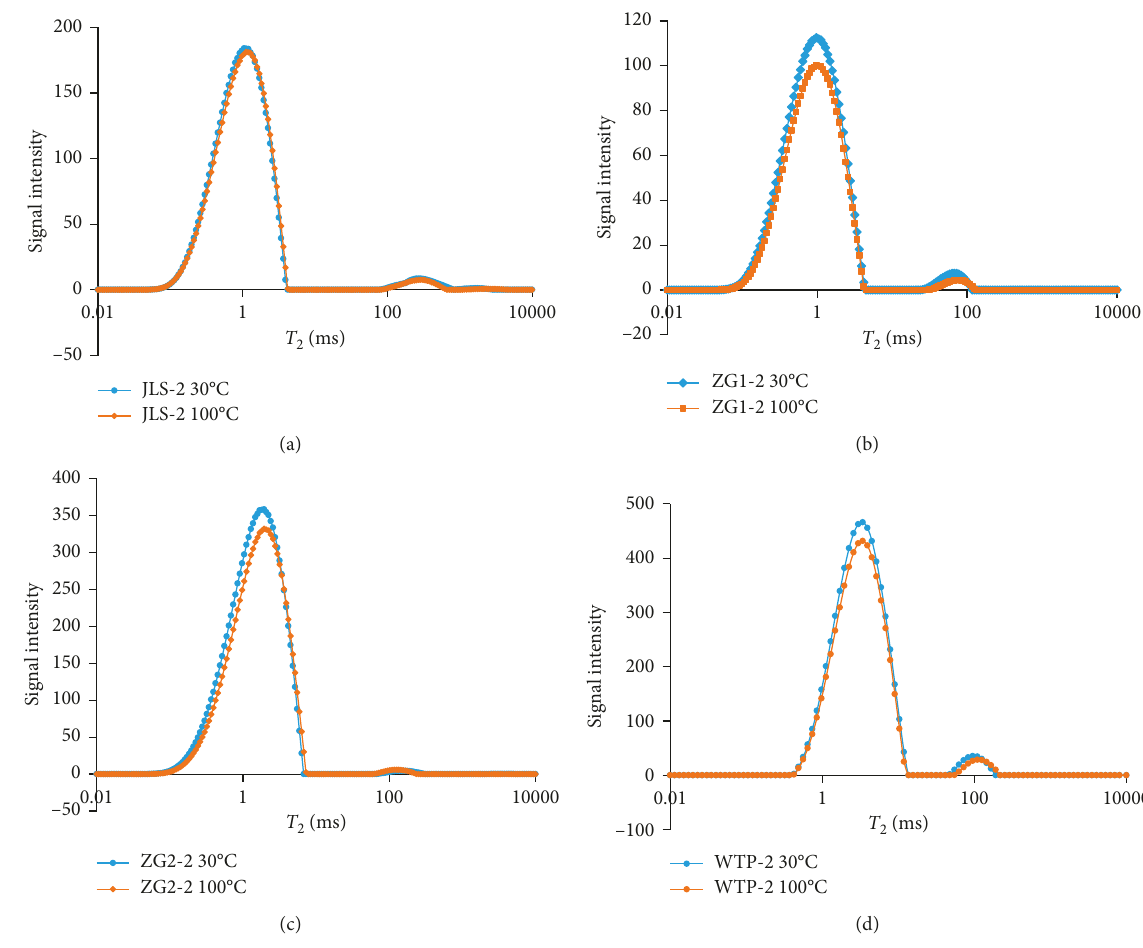
Figure 2: T 2 spectra of coal samples under high-temperature conditions.